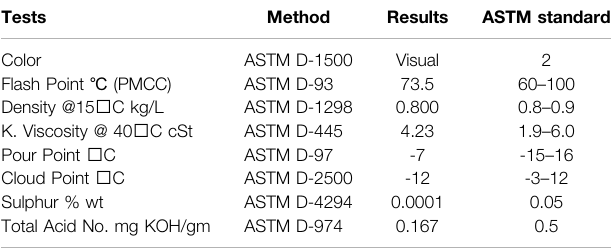
TABLE 7 | Fuel properties of Cucmis melo var. agrestis